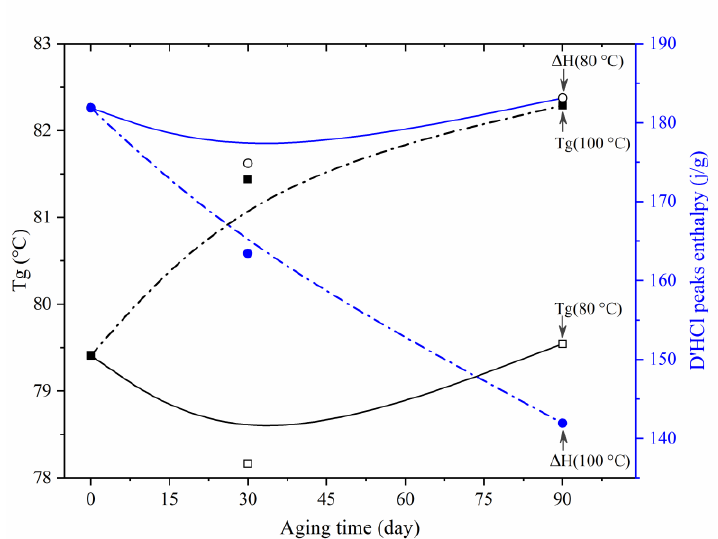
Fig. 5. Evolution of the glass transition temperature and dehydrochlorination peak enthalpy of (u-PVC) aged at 80 °C and at 100 °C versus aging